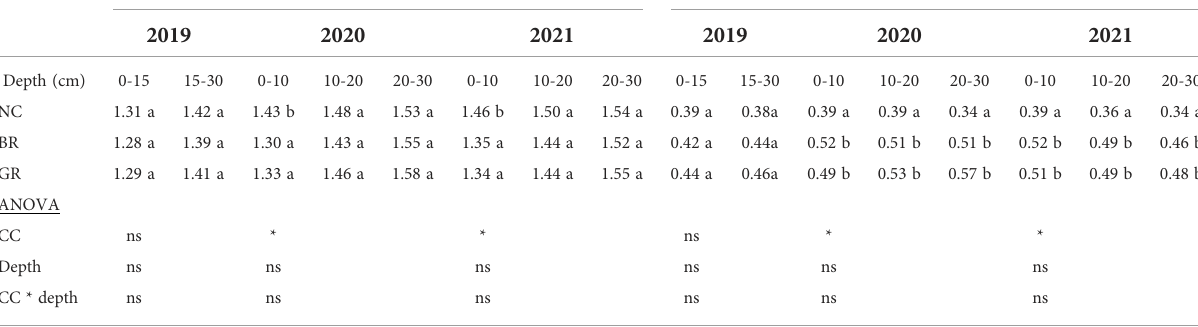
TABLE 4 Mean soil bulk density and aggregate stability at different depths in a 3- year soybean-rye rotation fi eld experiment sampled in spring 2019, fall 2020 and 2021 at Stoneville, MS, USA. Bulk density (g cm -3 ) Aggregate stability (> 0.25